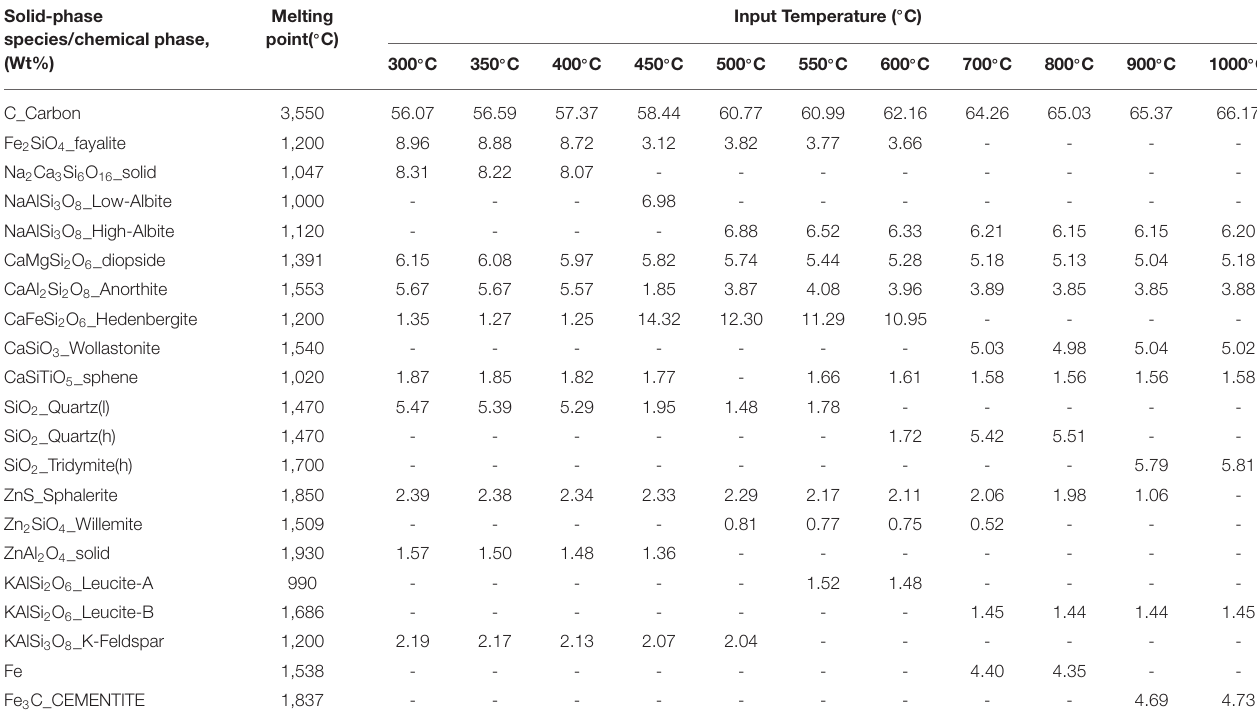
TABLE 3 | Predicted solid species as a function of temperature. Solid-phase species/chemical phase,